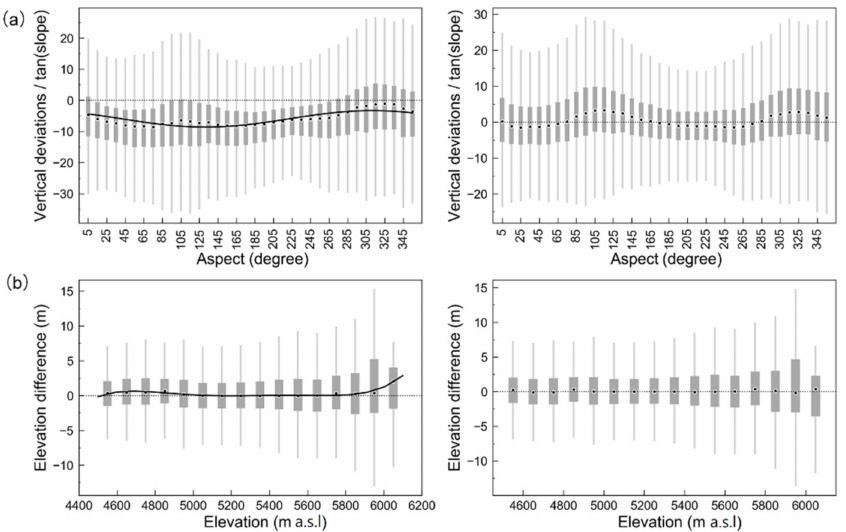
Figure 2. The distribution of elevation differences (dh) between the TanDEM-X and SRTM DEMs in relation to the aspect ( a ) and elevation ( b ) before and after systemic bias